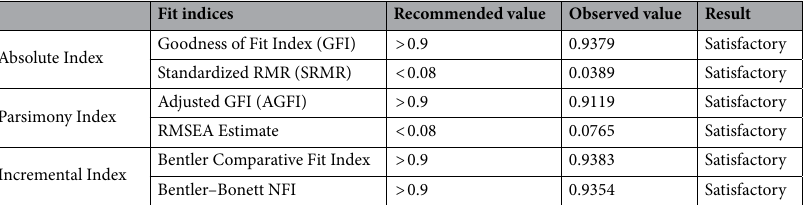
Table 3. Summary of fit indices from confirmatory factor